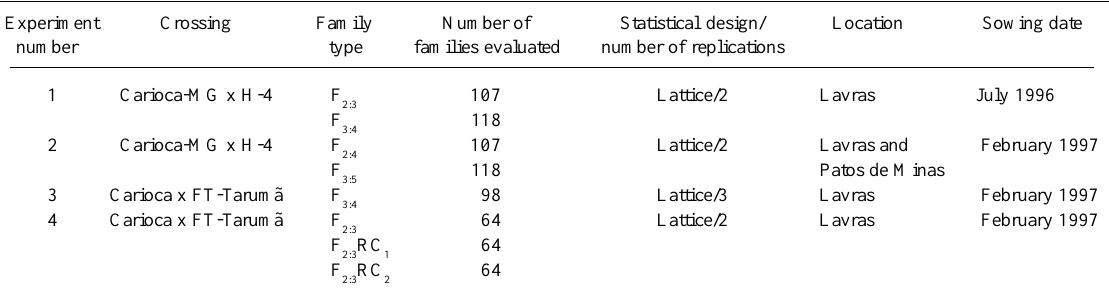
Table II - Description of the experiments in which bean families were evaluated.